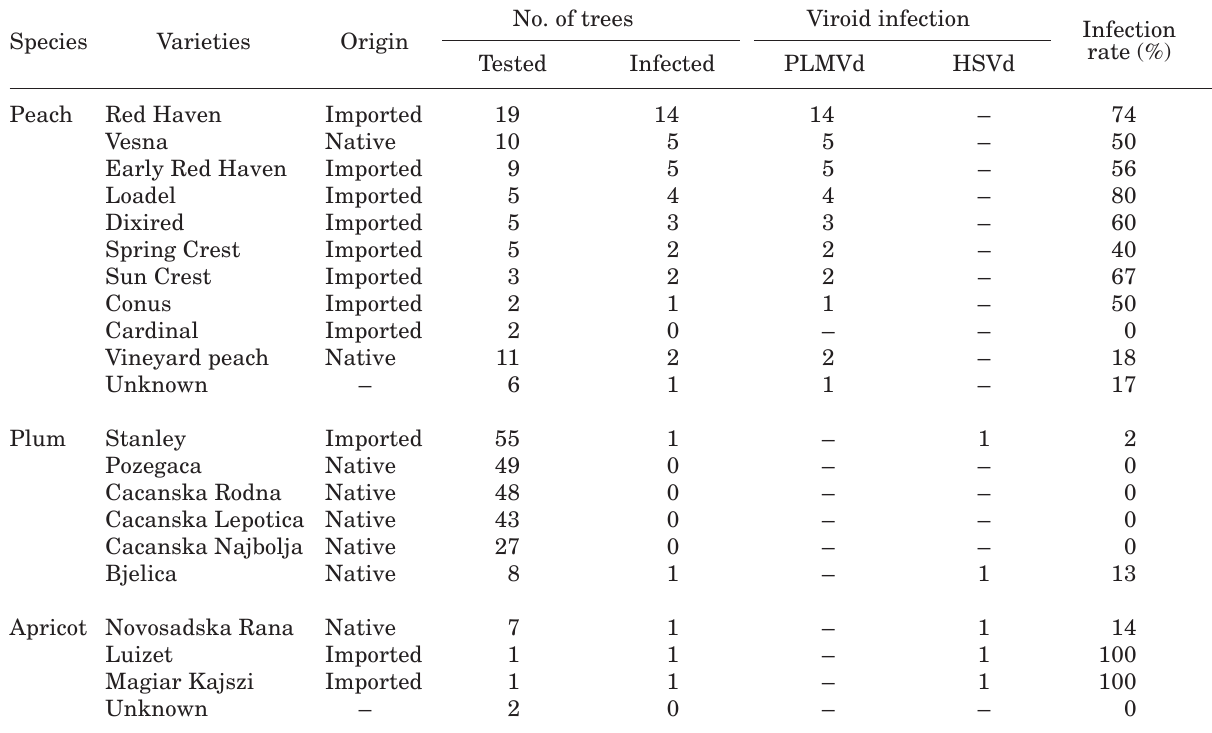
Table 2. Viroid infection related to Prunus cultivars.